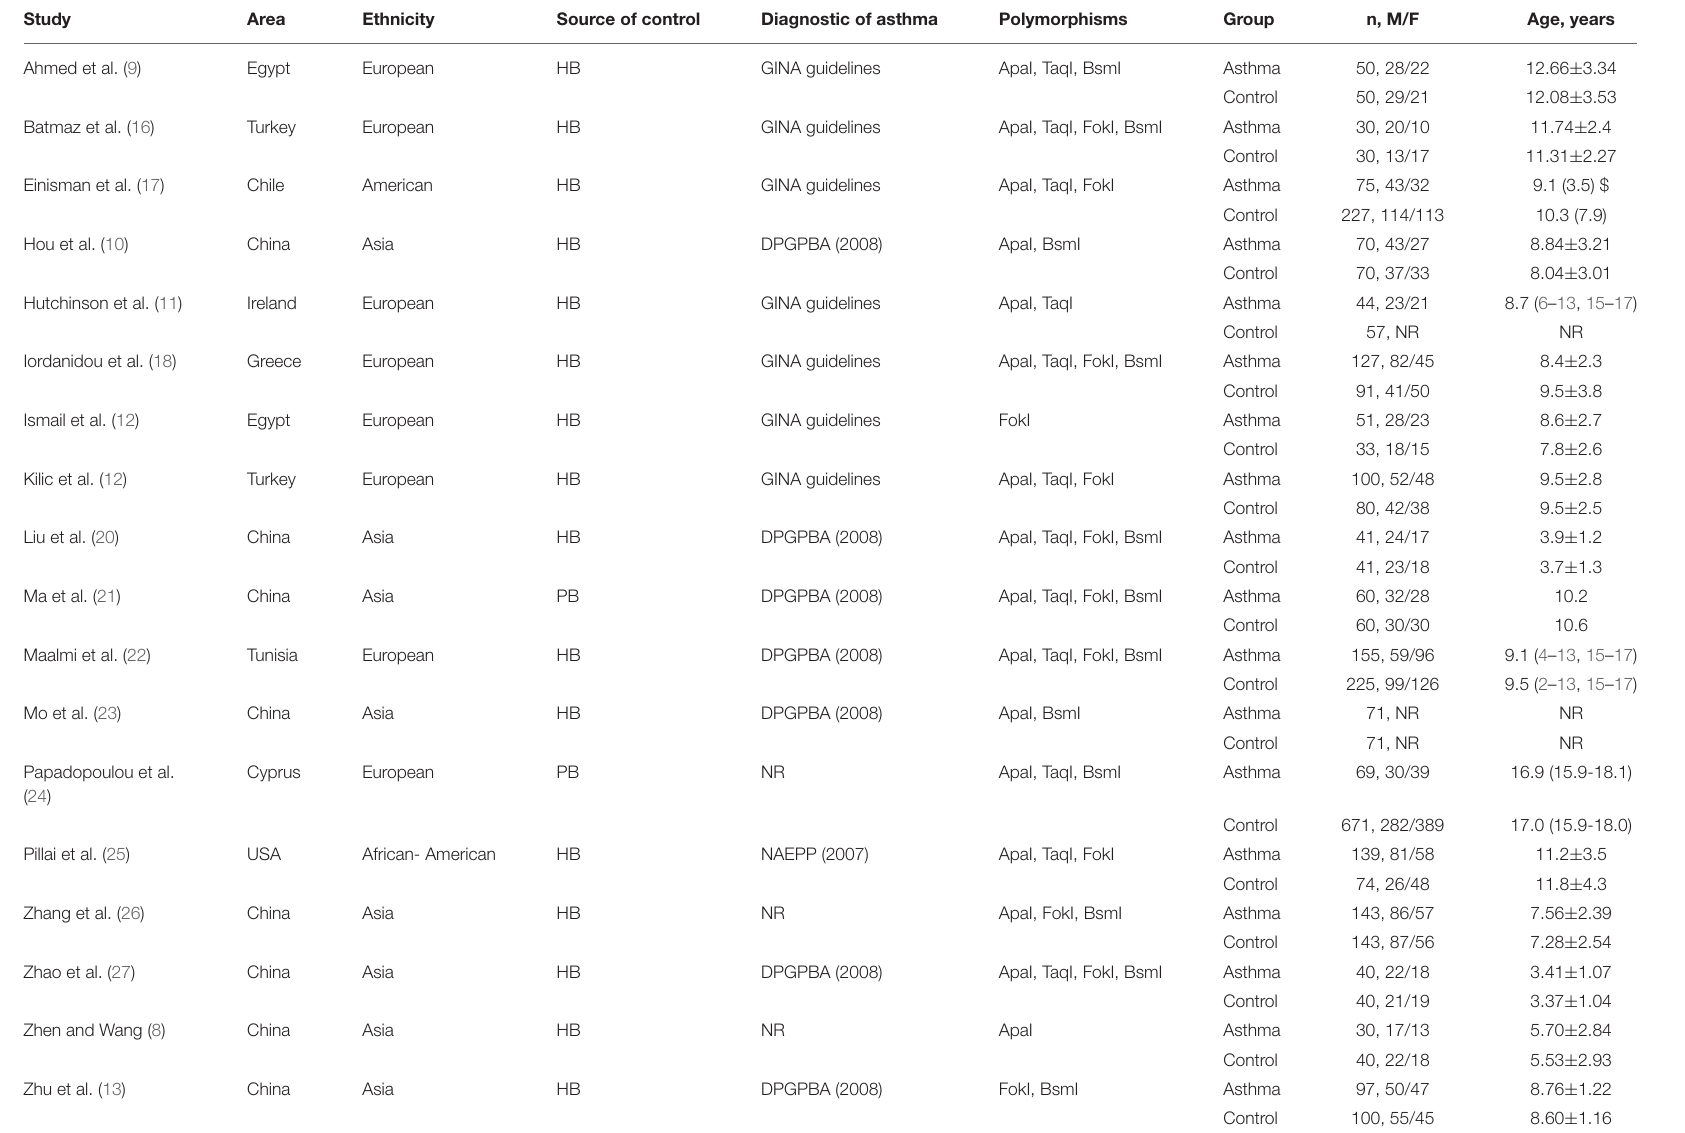
TABLE 1 | Characteristics of the included